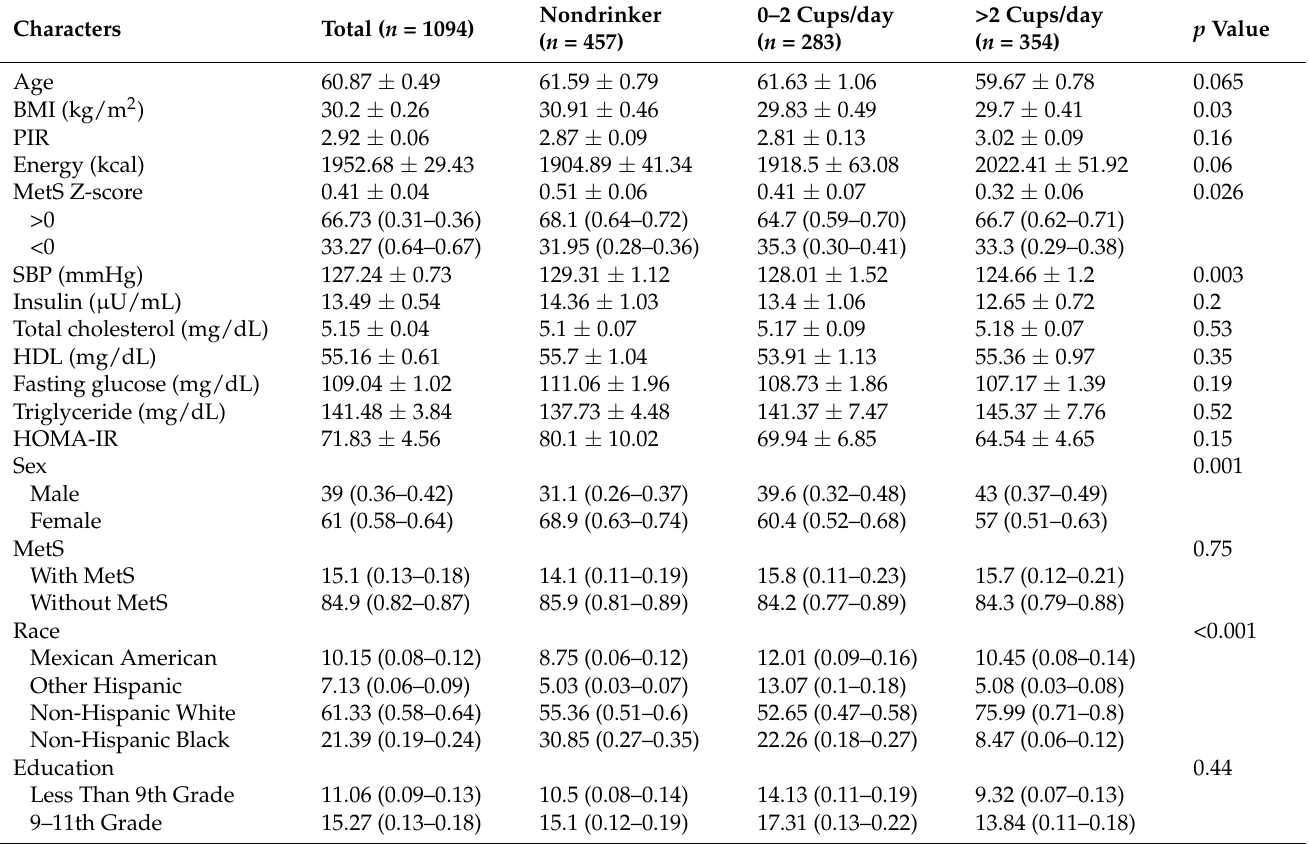
Table 1. Characteristics of the study population grouped by coffee intake, National Health and Nutrition Examination Survey (NHANES) 2003–2018 (n =